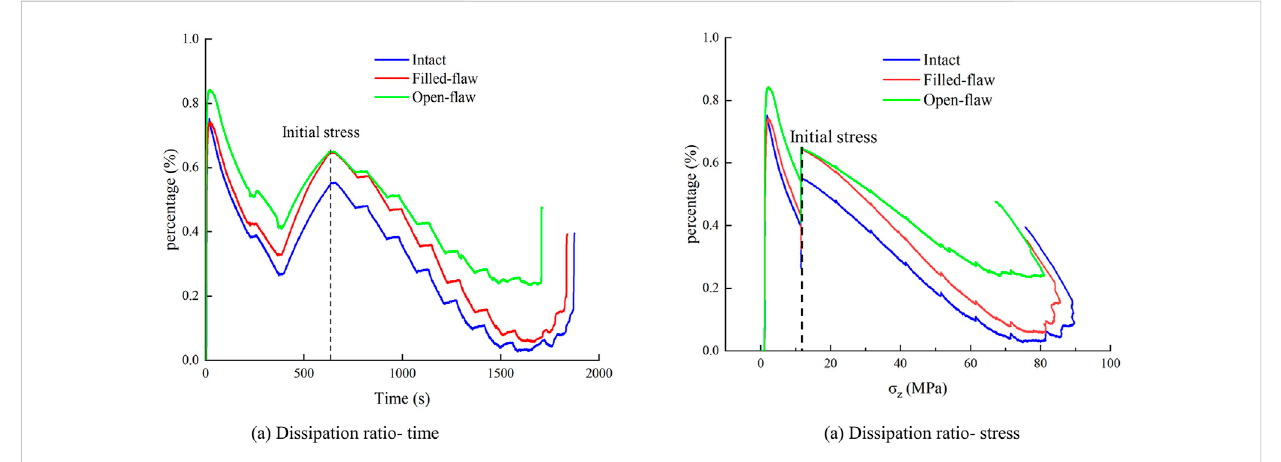
FIGURE 9 Dissipated energy ratio under the three surrounding rock conditions.